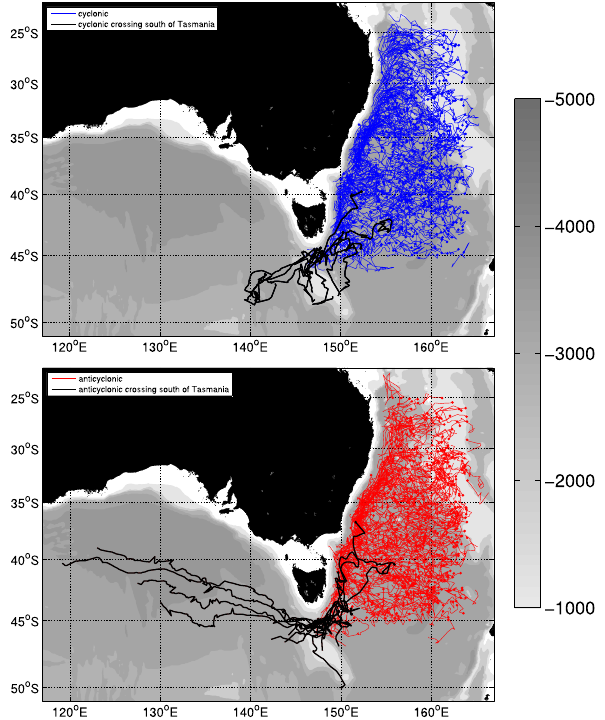
Figure 7. Trajectories of (a) cyclonic and (b) anticyclonic eddies first identified in the EAC system between October 1992 and April 2012. Eddy tracks that cross south of Tasmania are shown in